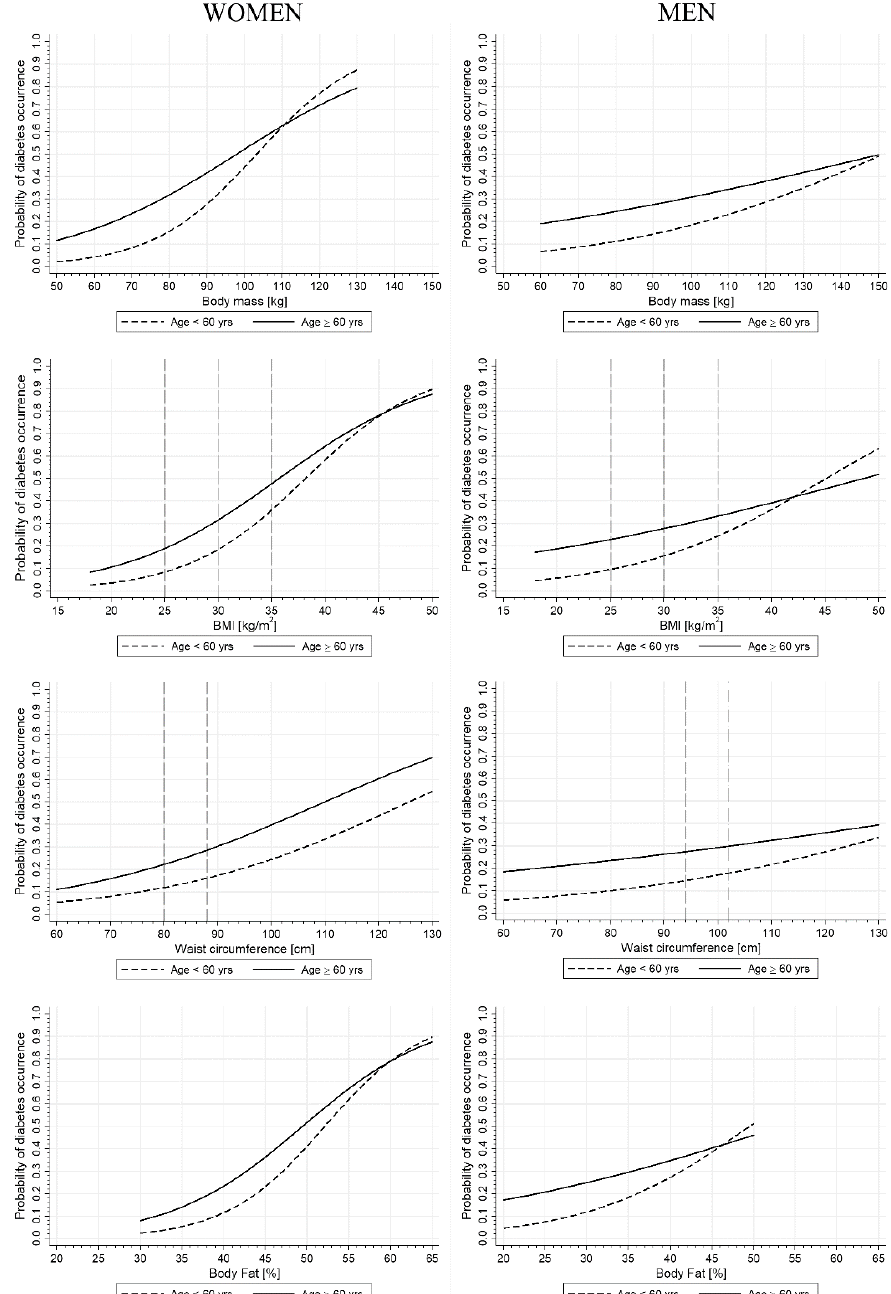
Figure 3. Probability of diabetes occurrence in younger and older men and women in relation to anthropometric parameters. Body mass index (BMI) of 25 kg/m 2 was associated with the probability 1. Bednarek, A.M.; Owczarek, A.J.; Chudek, A.; Almgren ‐ Rachtan, A.; Wieczorowska ‐ Tobis, K.; Olszanecka ‐ Glinianowicz, M.; of diabetes of 8.3% and 18.9% in younger and older women, respectively, and of 9.5% and 22.9% in Chudek, J. The Prevalence of Diabetes among Hypertensive Polish in Relation to Sex ‐ Difference in Body Mass Index, Waist younger and older men, respectively. BMI 30 kg/m 2 with 18.4% and 31.6% in younger and older Circumference, Body Fat Percentage and Age. Int. J. Environ. Res. Public Health 2022 , 19 , 9458. women, respectively, and 15.6% and 27.8% in younger and older men, respectively. BMI 35 kg/m 2 with 36.0% and 47.7% in younger and older women, respectively, and 24.4% and 33.2% in younger and older men, respectively. Waist circumference (WC) of 80 cm with 11.9% and 22.2% and 88 cm with 16.0% and 28.5% in younger and older women, respectively. WC of 94 cm with 14.5% and 27.4% and 102 cm with 17.8% and 29.9% in younger and older men, respectively. The doubling of the diabetes probability (from 25% to 50%) was attributable to the lower increase in body mass, WC, and BMI in women than in men (15.1 kg and 25.9